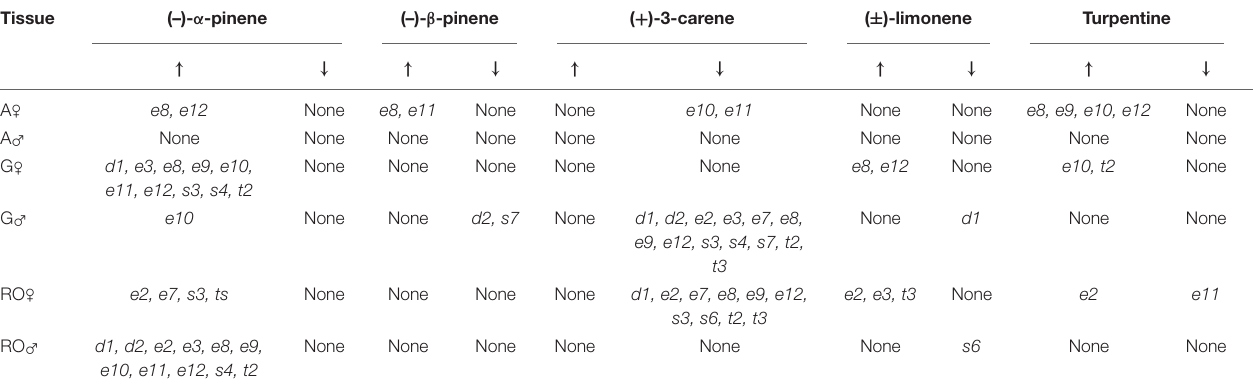
FIGURE 6 | Quantitative expression of GST genes in different tissues of different sexes in Dendroctonus armandi . Antennae (A), gut (G), and reproductive organs (RO). GST expression was normalized to the transcription level geometric mean of β - actin and CYP4G55 . Statistically significant differences in gene expression between sexes, tissues and sex*tissue are indicated with asterisks ( ∗ P < 0.05, ∗∗ P < 0.01, ∗∗∗ P < 0.001). The 2 - (cid:49)(cid:49) Ct and SE values were log 2 transformed for plotting. Statistically significant differences in gene expression are shown in Supplementary Table S6 . TABLE 3 | Significant difference of GST genes express trend (mean ± SE, n = 3) in different adult tissues [antennae (A), gut (G), and reproductive organs (RO)] of Dendroctonus armandi after terpenoids treatment for 8